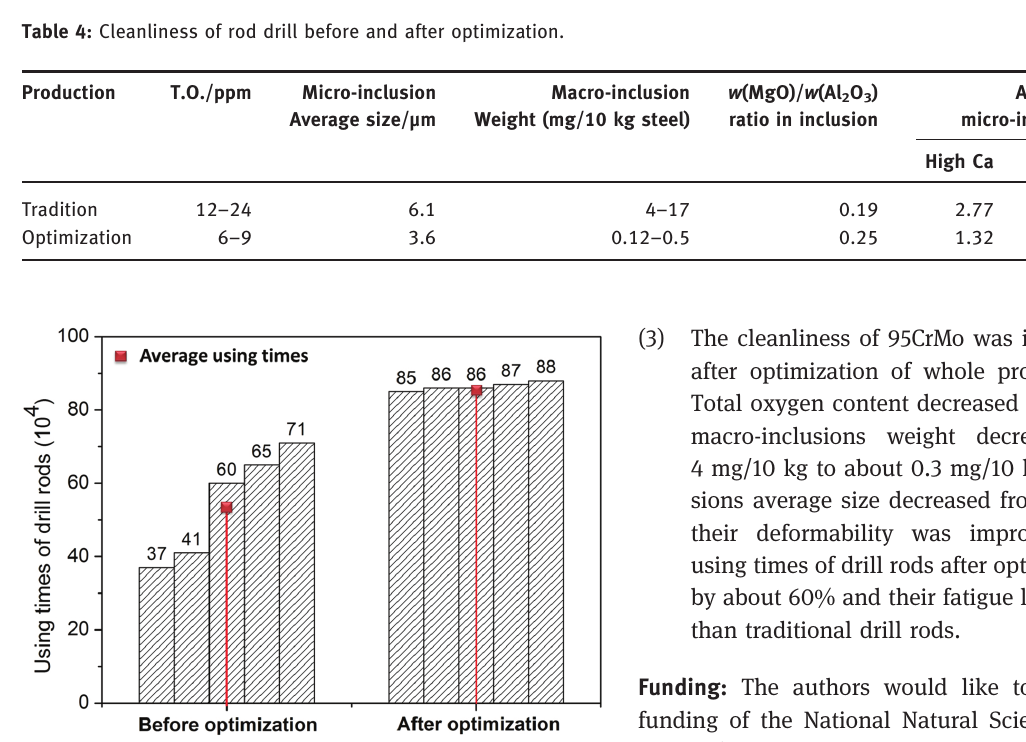
Figure 14: Using times of drill rods produced before and after